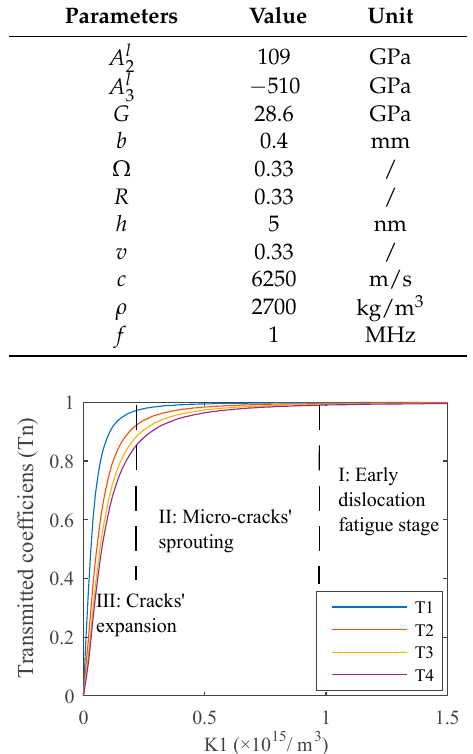
Figure 3. Relationship between the transmitted coefficient of each order harmonic (the fundamental wave T 1 , the second-order harmonics T 2 , the third-order harmonics T 3 , the fourth-order harmonics T 4 ) and spring stiffness.